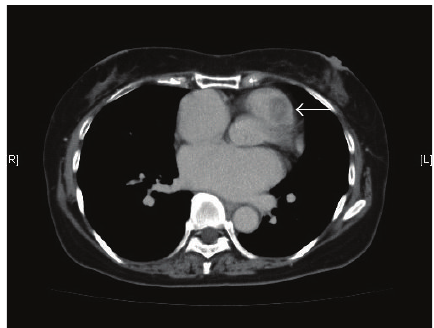
Figure 2: Chest computed tomography displays the tumor (white arrow) in the right ventricular outflow tract.